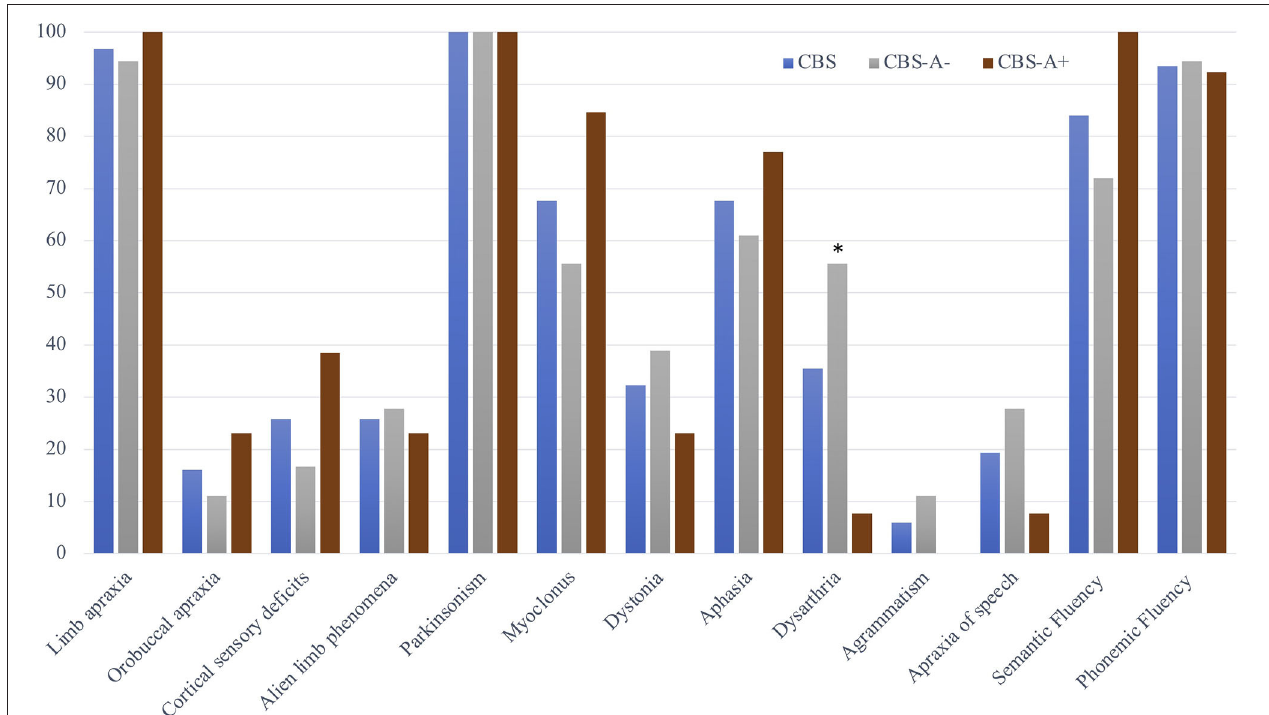
FIGURE 1 | Motor, cortical, and language deficits in the whole CBS cohort and according to subgroups with positive (CBS-A + ) and negative (CBS-A–) amyloid-PET. Data are presented as the frequency of the symptoms or the percentage of altered verbal fluency tasks among the CBS sample and in the subgroups according to cortical amyloid deposition. The symbol * indicates statistically significant differences between CBS-A + and CBS-A– groups. Dysarthria 10/18, 55.6% vs. 1/13, 7.7%, p = 0.008, Fisher’s exact test.